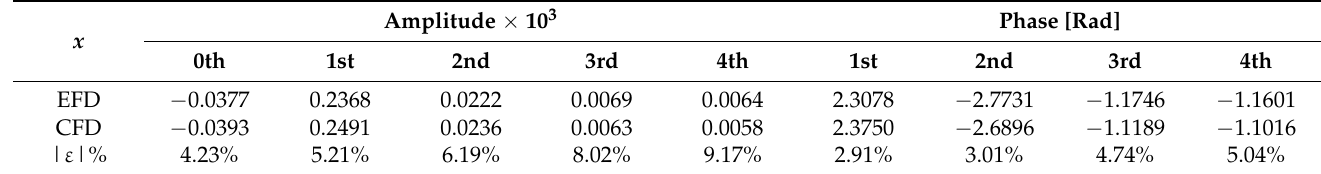
Table 25. Harmonic amplitudes and phases of surge for the FRxz ϕθ following waves scenario.